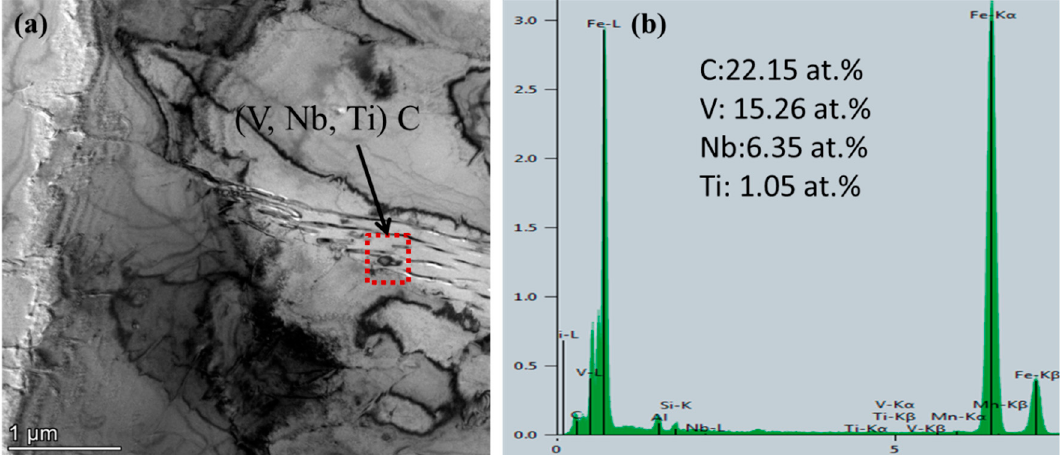
Figure 15. Images of (V, Nb, Ti) C precipitates in the experimental steel at 650 °C for five passes of thermal simulation. Images of ( a ) (V, Nb, Ti) C precipitates and ( b ) EDS of Nb, V, and Ti.